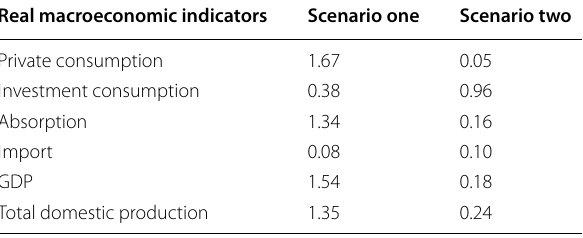
Table 7 Real macroeconomic effects (percentage